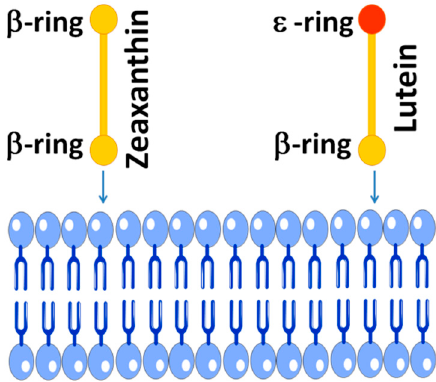
Figure 3. Schematic drawing showing the preferential lutein β -ring-intercalation into the lipid membrane based on molecular dynamics study of Makuch et al. (for more details, see Ref. [127]). Two macular xanthophylls are shown: symmetrical zeaxanthin with two β -rings and asymmetrical lutein with one β -ring and one ε -ring.